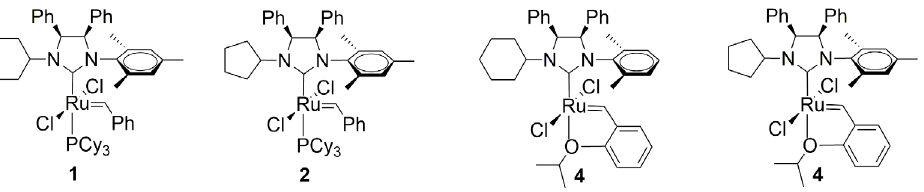
Figure 2. Ruthenium catalysts bearing N -cycloalkyl, N ′ -mesityl NHC ligands used in this study.